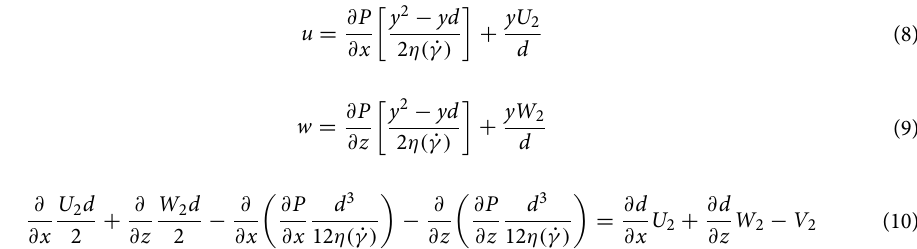
The boundary conditions of MR fluid are: y 1 = 0, u 1 = v 1 = w 1 = 0; y 2 = d , u 2 = U 2 , v 2 = V 2 , w 2 = W 2 . The boundary conditions are substituted into the velocity expression, fluid dynamic pressure expression and apparent viscosity expression of MR fluid to obtain Eqs. (8–10) 24 .